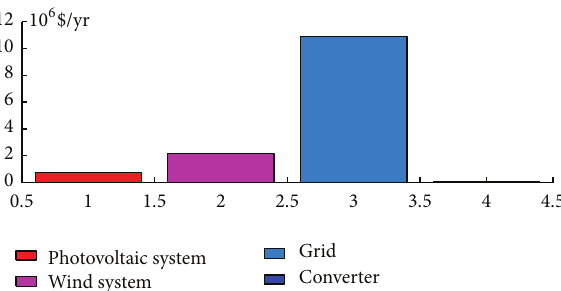
Figure 13: Net present cost.